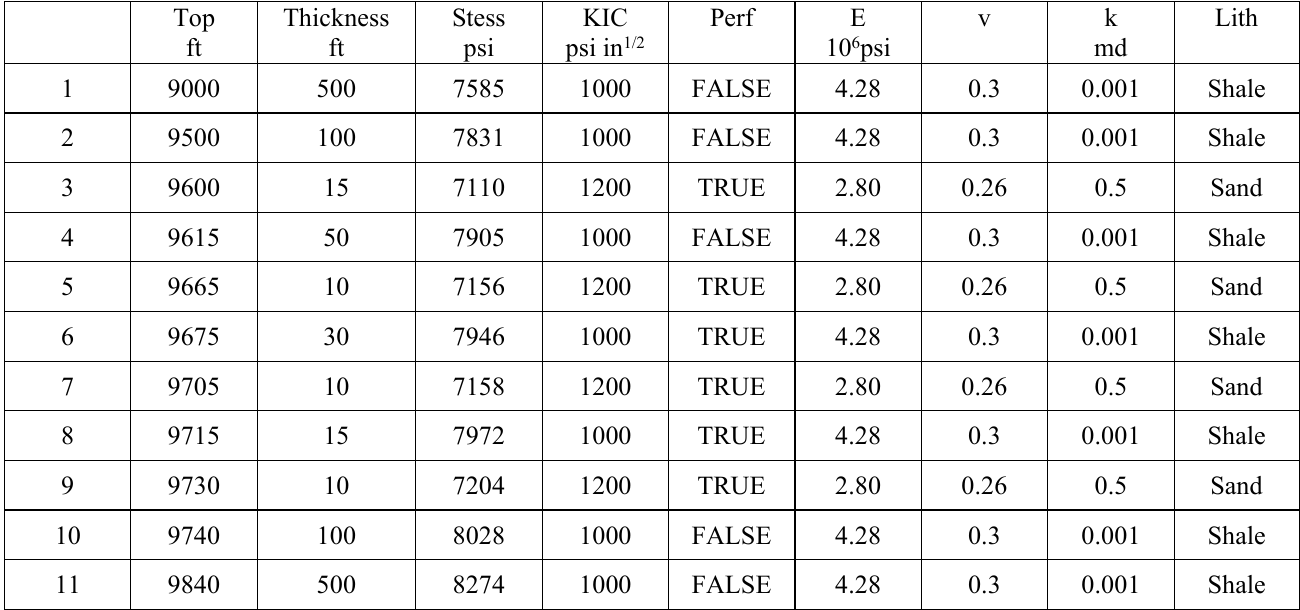
Table 1—Reservoir layer data.